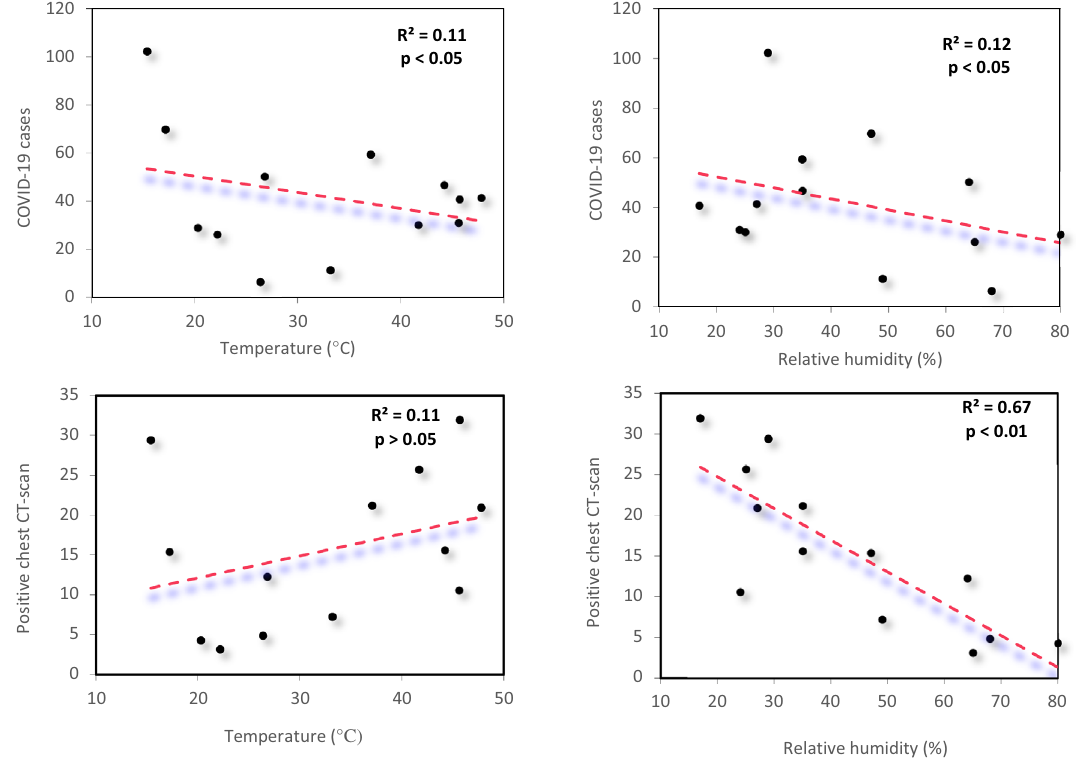
Fig. 5 Correlation between average a air temperature and a' relative humidity with new cases of COVID-19 admitted to the Petroleum Hospital, and b , b' positive chest CT scan in Ahvaz between March 2020 and March